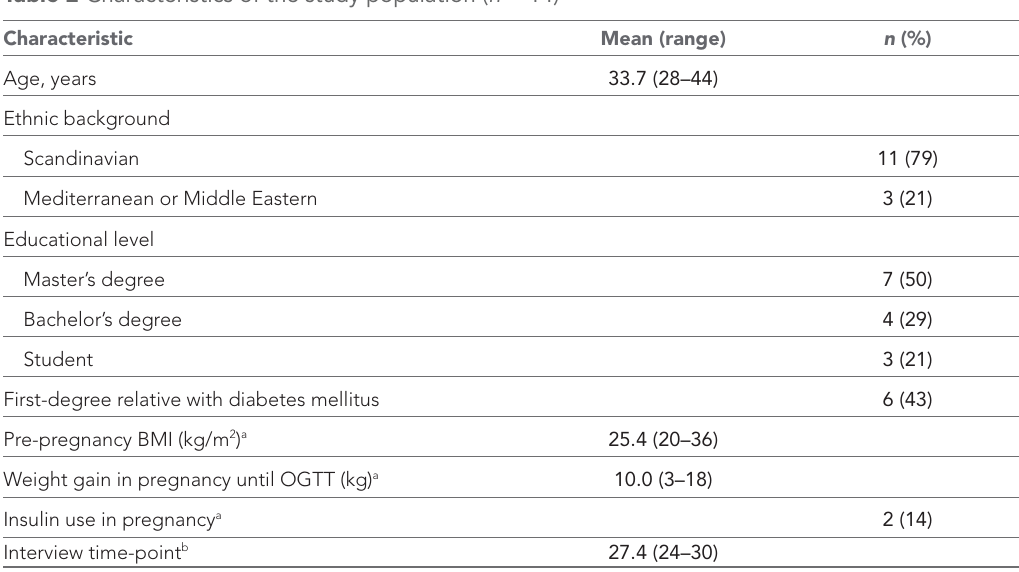
Table 2 Characteristics of the study population ( n =